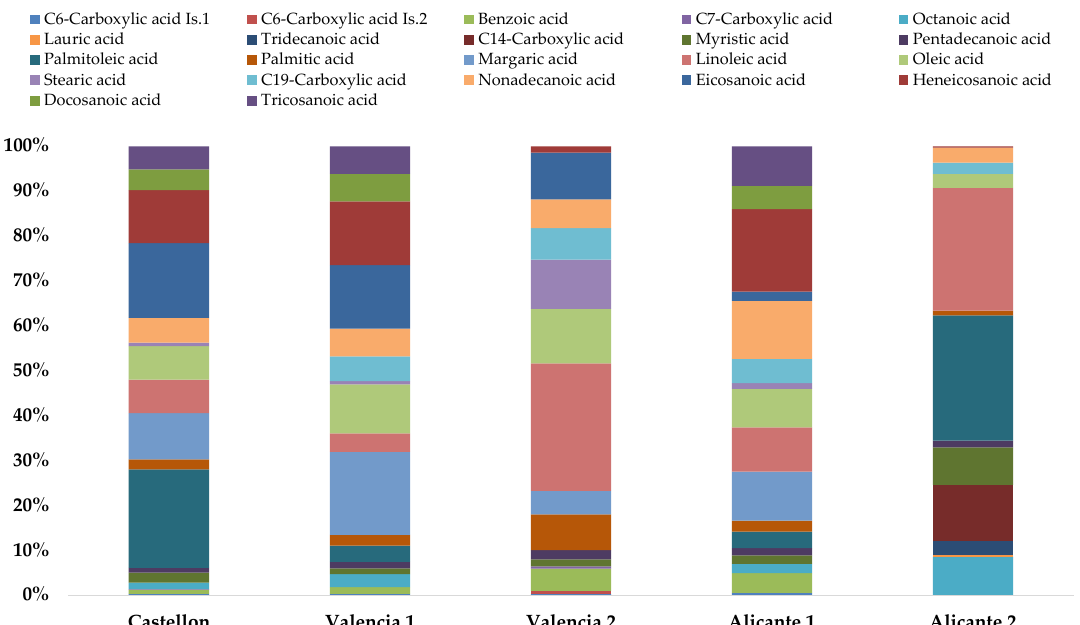
Figure 3. The average concentrations of MCAs (in percentage) in fine PM at 5 western Mediterranean areas studied. Total average mass concentrations were 1688, 1637, 1038, 2354, and 1090 ng m − 3 for Castellon, Valencia 1, Valencia 2, Alicante 1, and Alicante 2, respectively.